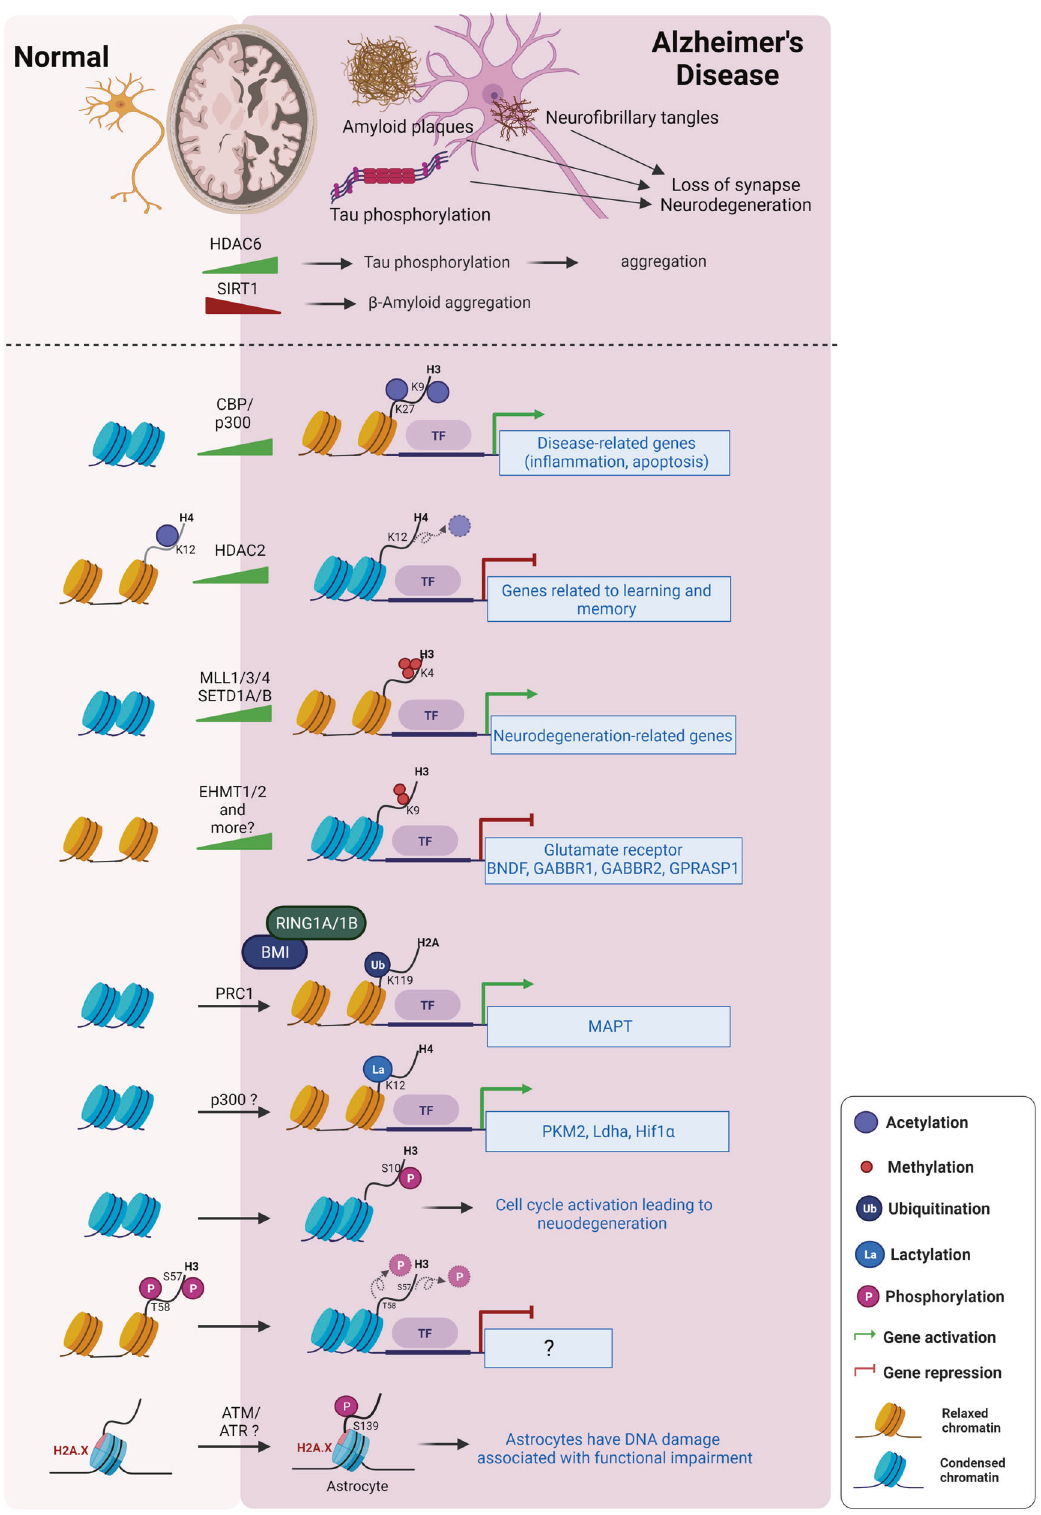
Fig. 5 Dysregulation of histone-modifying enzymes and histone modi fi cations in Alzheimer ’ s disease (AD). Histone acetylation such as H3K9ac and H3K27ac is globally increased due to the increase of CBP/p300 expression. In contrast, acetylation of H3K12 is reduced by the increased HDACs (e.g., HDAC2). In AD, HMTs responsible for H3K4me3 and H3K9me2 are overexpressed: SETD1A/1B and MLL3/4 for H3K4me3, GLP/G9a (EHMT1/2) for H3K9me2. These affect the levels of H3K4me3 and H3K9me2 on a global and gene-speci fi c level, thereby altering gene expression. H2A ubiquitination (H2AK119ub by PRC1), H3 lactylation (H3K12la by p300), H2A.X phosphorylation (H2A.XS139p) are increased in AD. SIRT1 downregulation in AD leads to the elevated A β levels and their aggregation. HDAC6 increase in AD stimulates tau phosphorylation, thereby facilitating tau aggregation Signal Transduction and Targeted Therapy (2022)